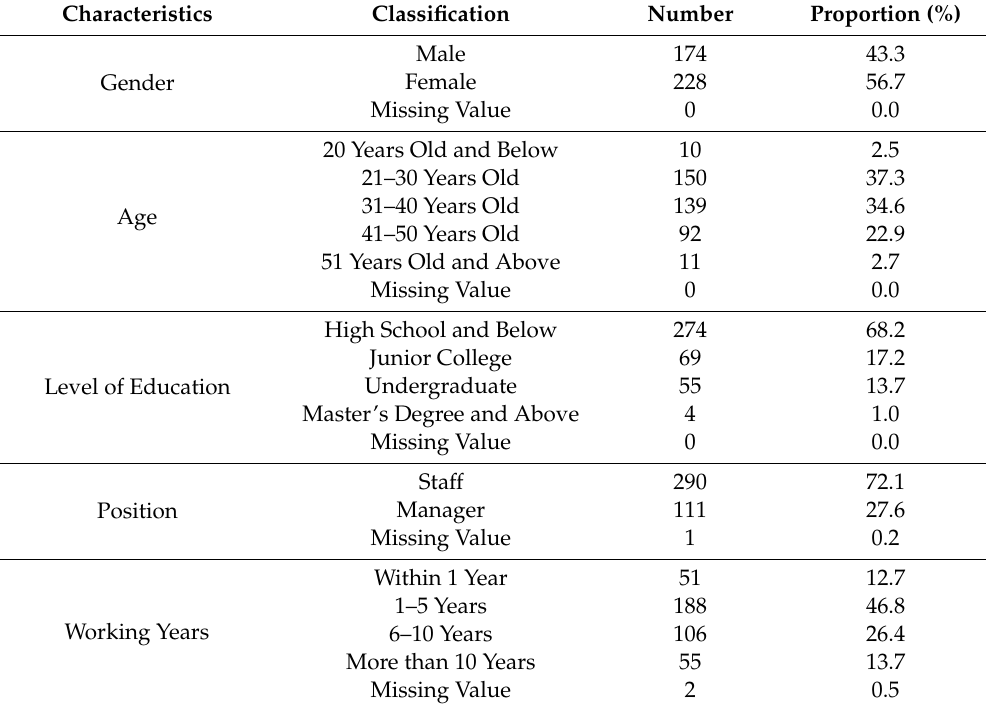
Table 2. Basic statistics of